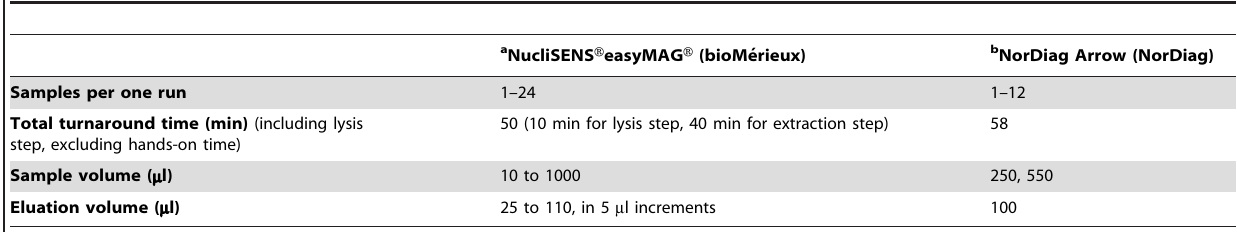
Table 3. Comparative analysis of the technical aspects of NucliSENS H easyMAG H and NorDiag